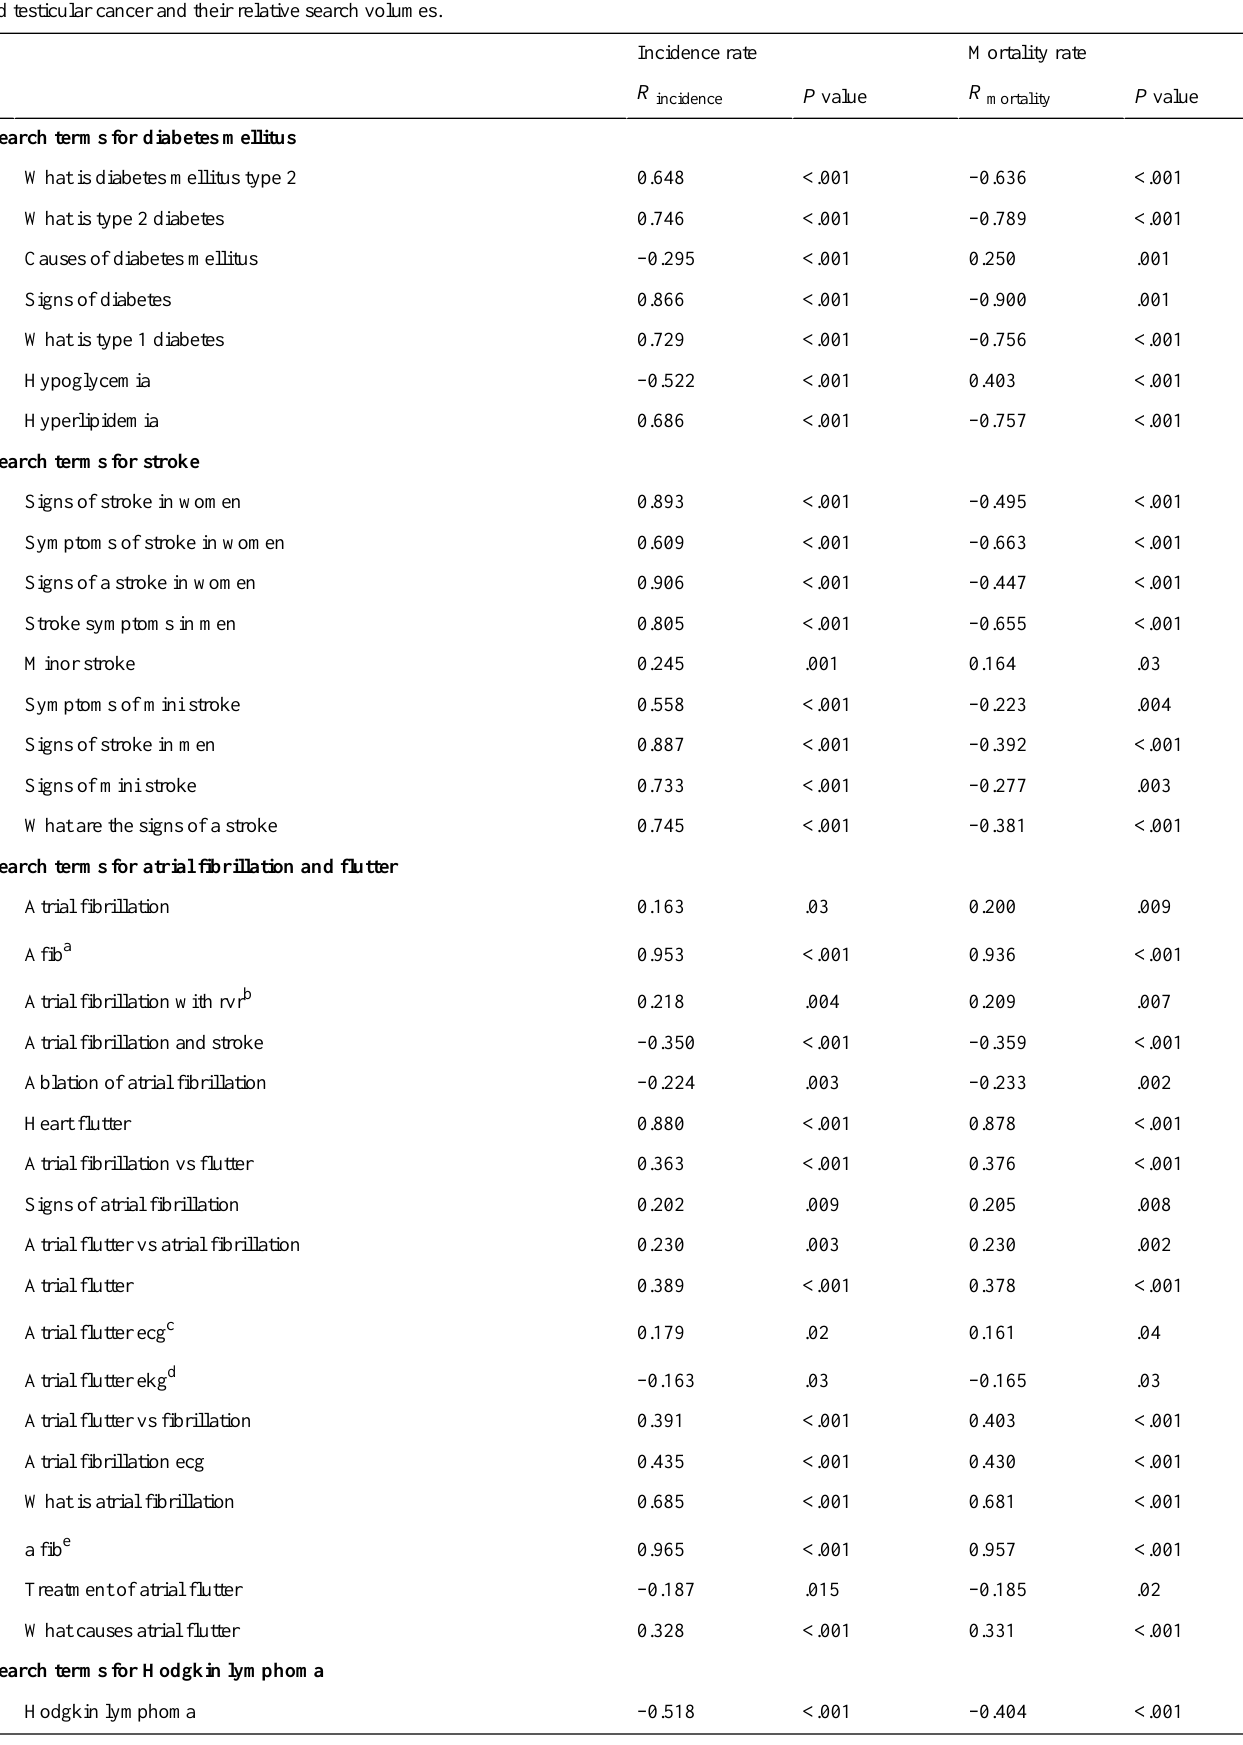
Table 1. Correlation coefficients between the incidence and mortality rates of diabetes mellitus, stroke, atrial fibrillation and flutter, Hodgkin lymphoma, and testicular cancer and their relative search